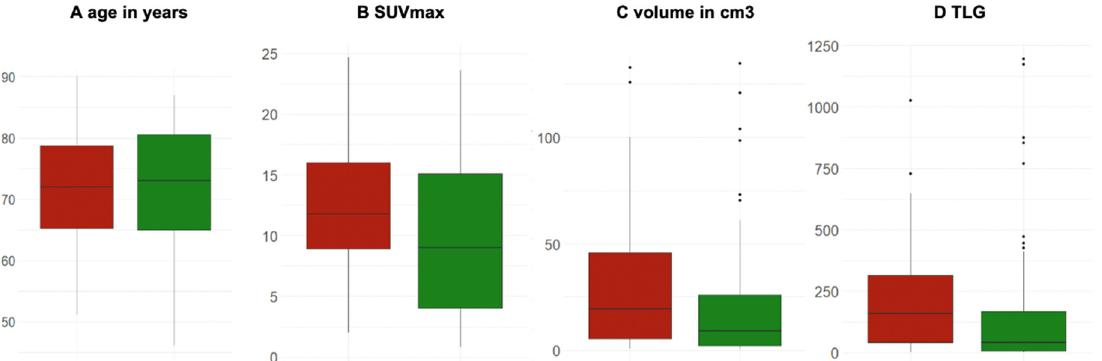
Figure 2. Box plots of the significant predictors for long-term responses in patients treated with ICI (red) vs. no ICI (green). ( A ) Age in years ( p = 0.64); ( B ) SUVmax unitless ( p = 0.09); ( C ) volume in cm 3 ( p < 0.01), and ( D ) TLG (unitless) ( p = 0.13).